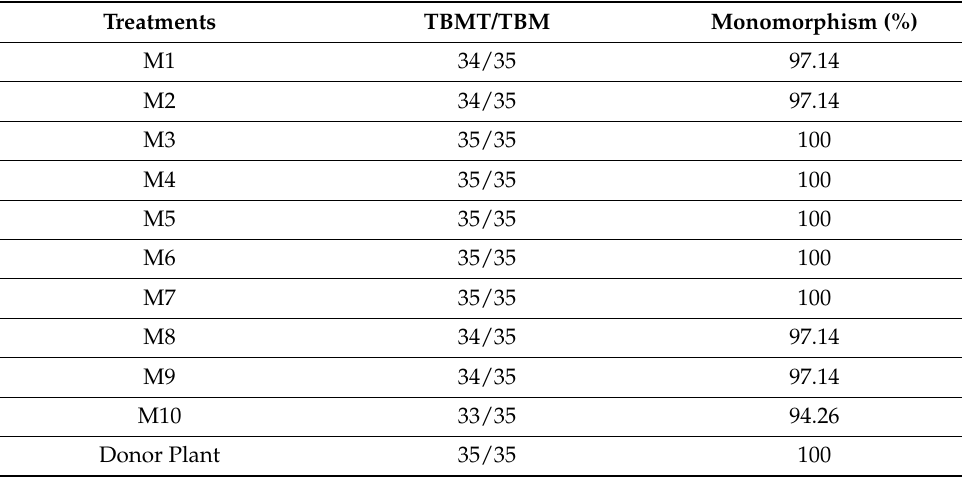
Table 5. Levels of genetic stability detected by ISSR in the evaluated